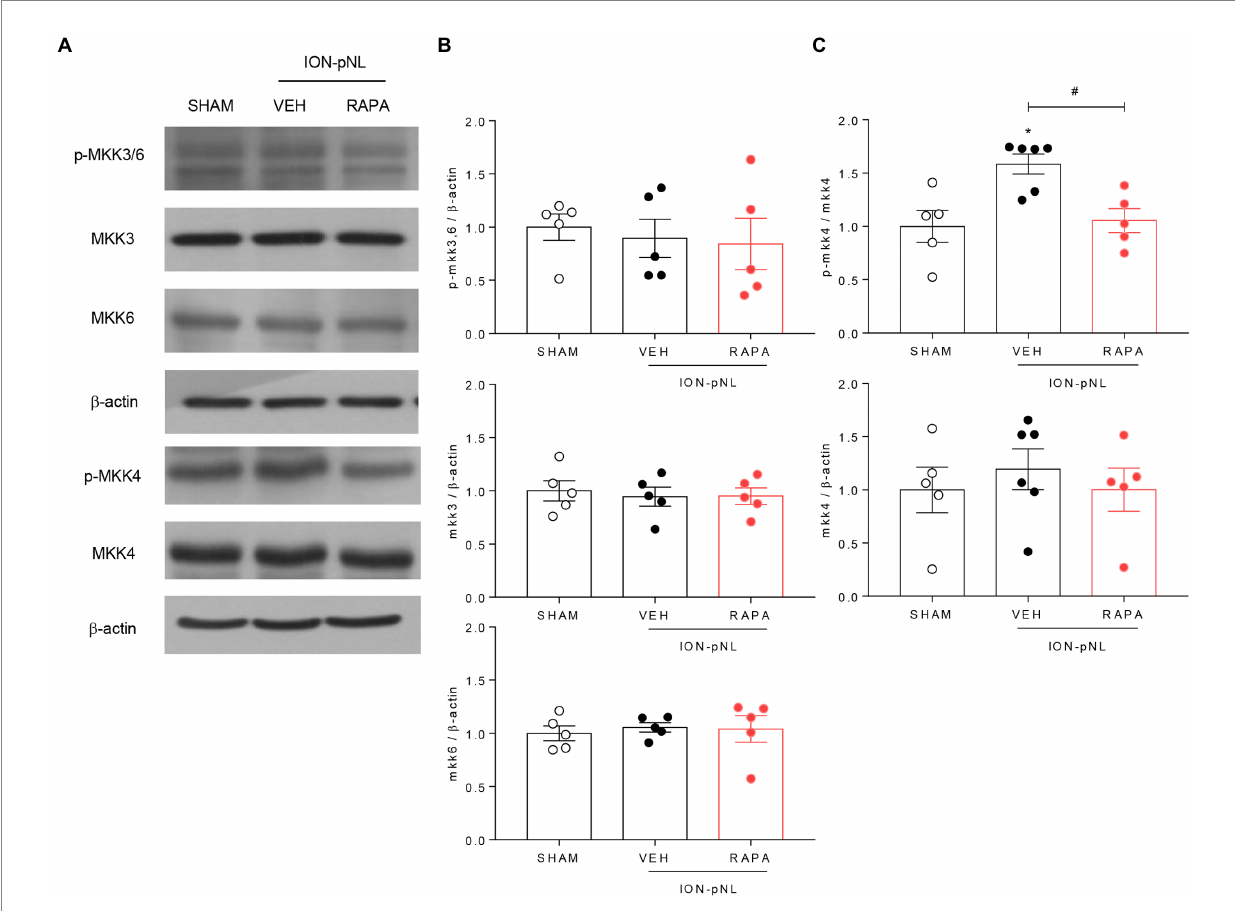
FIGURE 8 Effect of rapamycin on MKK3, MKK6, and MKK4 in the TNC. Both p-MKK3 and p-MKK6 expressions were unchanged in the ION-pNL group compared with the SHAM group, and RAPA had no effect on p-MKK3 and p-MKK6 expressions compared with the VEH-treated group (A,B) . On the other hand, p-MKK4 expression significantly increased in the ION-pNL group (A,C) , and RAPA restored the increased p-MKK4 expression after ION-pNL (A,C) . * p < 0.05 and # p < 0.05 compared with the SHAM group and VEH group, respectively, n = 5–6 per